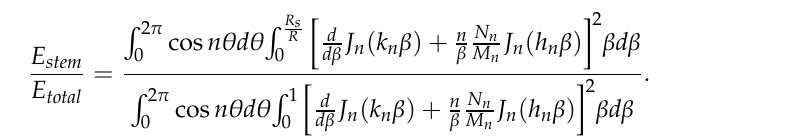
Figure 3. Comparison between the Q anchor and Q SFD values of each WGM for the 37 μ m ( a ) and 18 μ m- radius resonators ( b ).